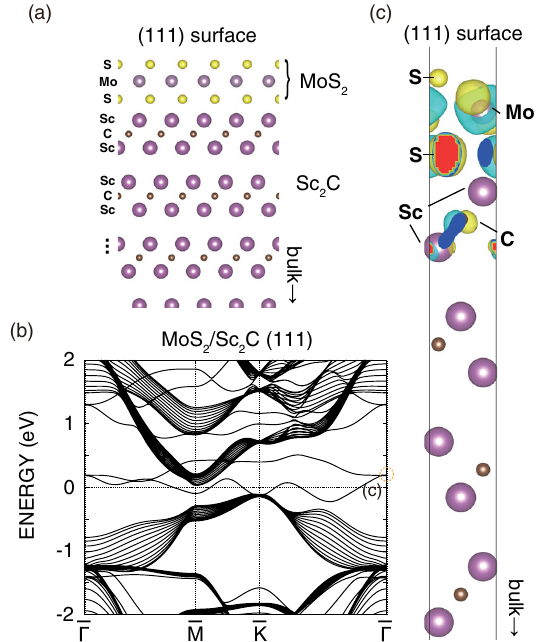
FIG. 4. Doping via topological surface charges of Sc 2 C. (a) Crystal structure of MoS 2 on the Sc 2 C (111) surface. (b) Electronic band structure of a MoS 2 monolayer on Sc 2 C. (c) Wave function of the eigenstate at the Γ point originating from the MoS 2 monolayer. The corresponding point is indicated by the dotted circle in (b). The energy is measured from the Fermi level.